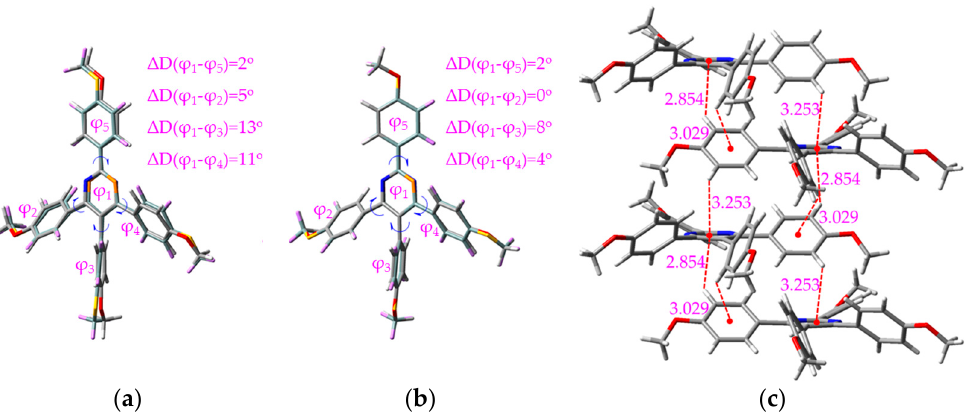
Figure 5. ( a ) Overlap diagram of optimized structures of S 0 and S 1 state of TPPM-4M in the gas phase and ( b ) in the crystal phase; ( c ) Single crystal packing diagram and intermolecular C–H ‧‧‧ π interactions (in angstrom) of TPPM-4M.